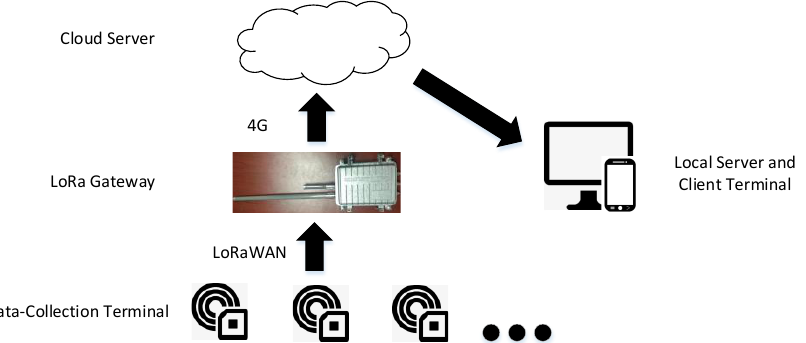
Figure 8. Network deployment based on LoRa technology.